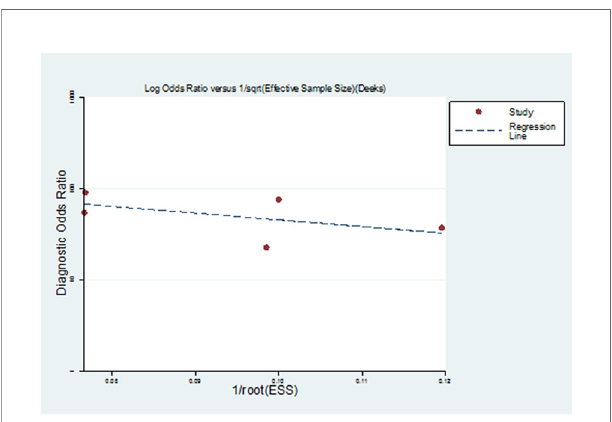
FIGURE 5 | Deeks funnel plot of studies included in the meta-analysis. There was no published bias in Deeks funnel plot of studies included in